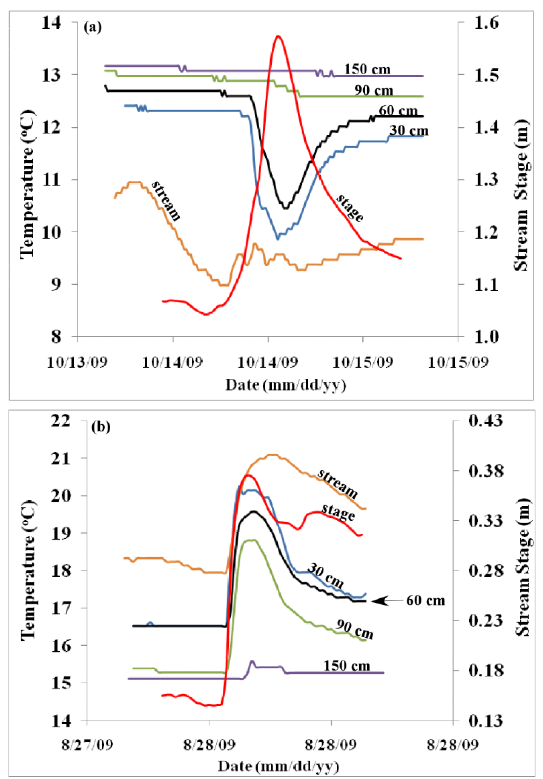
Figure 5. Representative after-storm substrate temperature response during the: ( a ) Cold period and ( b ) warm period.